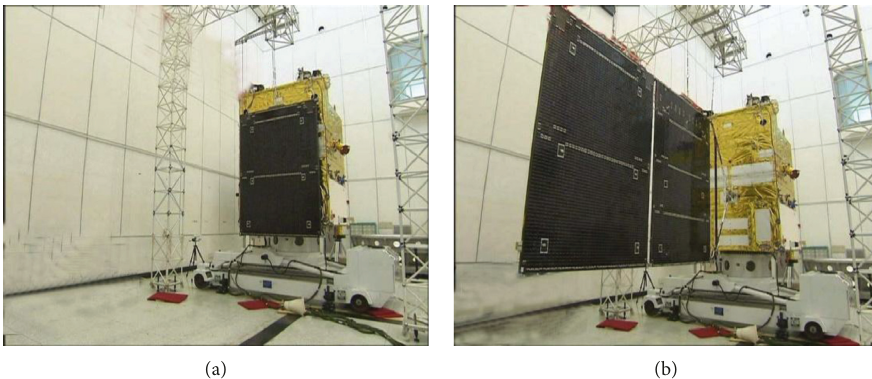
Figure 6: Ground deployment testing experiment of the GF-2 satellite solar array. (a) Before deployment. (b) Fully deployed.